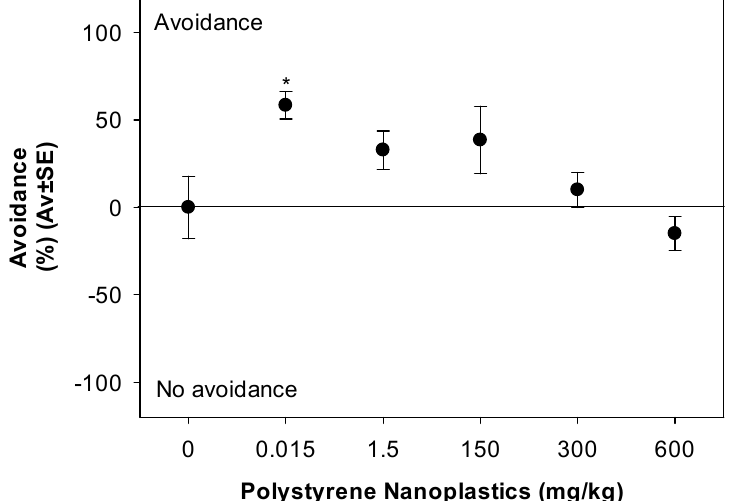
Figure 4. Avoidance responses of Enchytraeus crypticus after 48 h exposure to polystyrene nanoplastics (NPls) dispersion. Data are expressed as average value (AV) ± standard error (SE). * Significant differences to control ( p < 0.05).